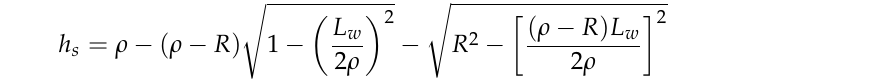
Figure 7. Effects of machining strategies on the surface roughness of a micro-lens array mold.